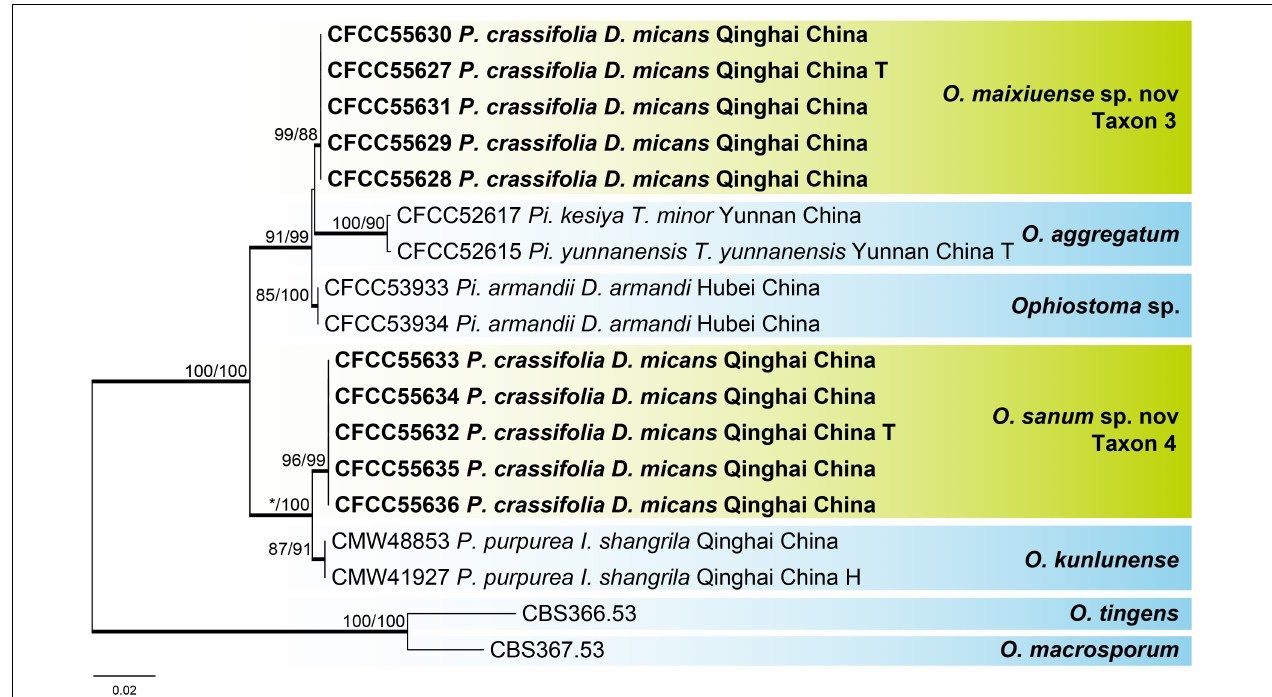
FIGURE 4 | Phylogram of lineage A (including taxons 3 and 4) based on combined (ITS + Tub2) sequence data. Bold branches indicate posterior probability values ≥ 0.9. The MP/ML bootstrap support values ≥ 70% are recorded at the nodes. D ., Dendroctonus ; I ., Ips ; P ., Picea ; Pi ., Pinus ; T ., Tomicus ; T, ex-type isolates.